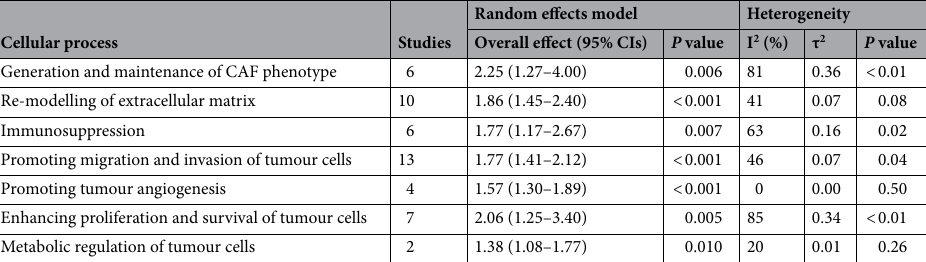
Table 4. Summary of results from the random effects models for each cellular process. The list of proteins making up each cellular process can be found in Table 3.